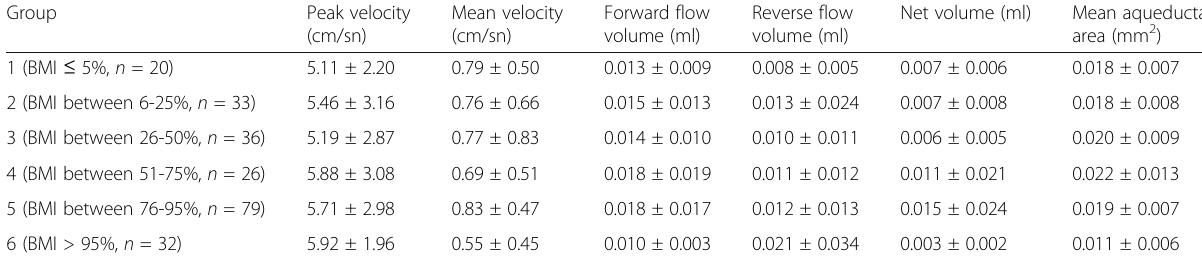
Table 4 An overview of phase contrast MRI parameters in various body mass index (BMI) groups